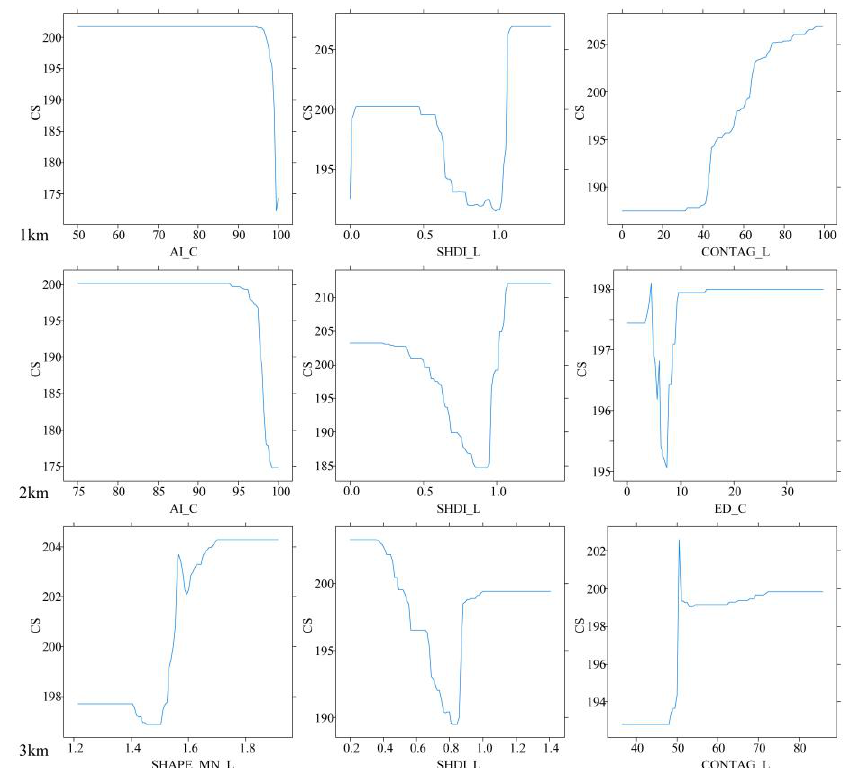
Figure 5. The partial dependence plots of CS on the three most important landscape metrics at different spatial scales.